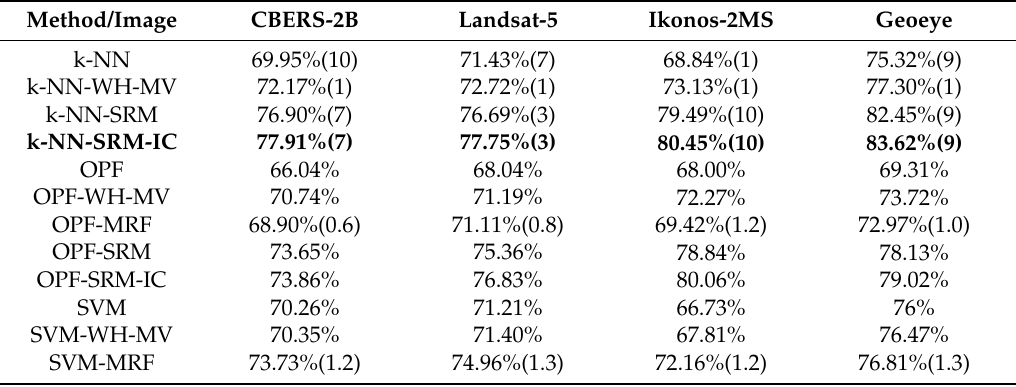
Table 4. The mean accuracy obtained by all methods on four land cover